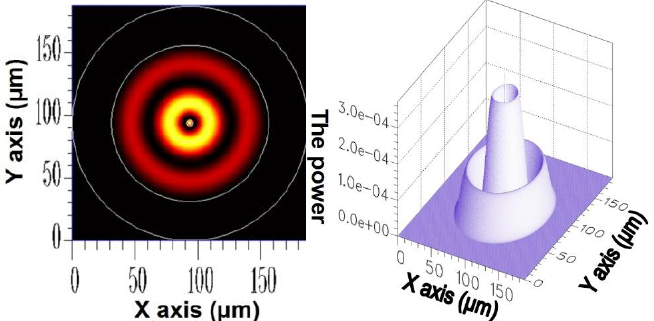
Figure 4. The 3D power diagram of the cladding mode ( ν = 3) with an effective refractive index of